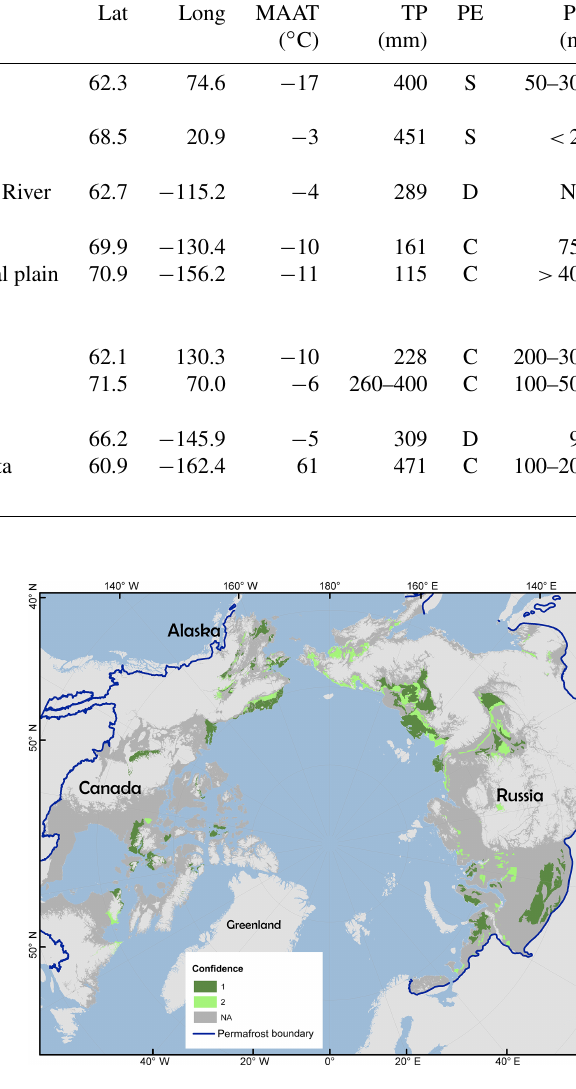
Figure 3. Confidence for permafrost lowland landscapes. Confi- dence class 1 (high confidence) designates permafrost landscapes where waterbody maps are available in lowland areas. Confidence class 2 (low confidence) represents permafrost landscapes with ex- trapolated waterbody statistics. No-value (dark grey) areas indicate that no maps were available in these permafrost landscapes. Light- grey areas indicate terrain with elevations (GTOPO 30, USGS) higher than 300ma.s.l. which were not considered in the extrapola- tion. Permafrost boundary was derived from the regional